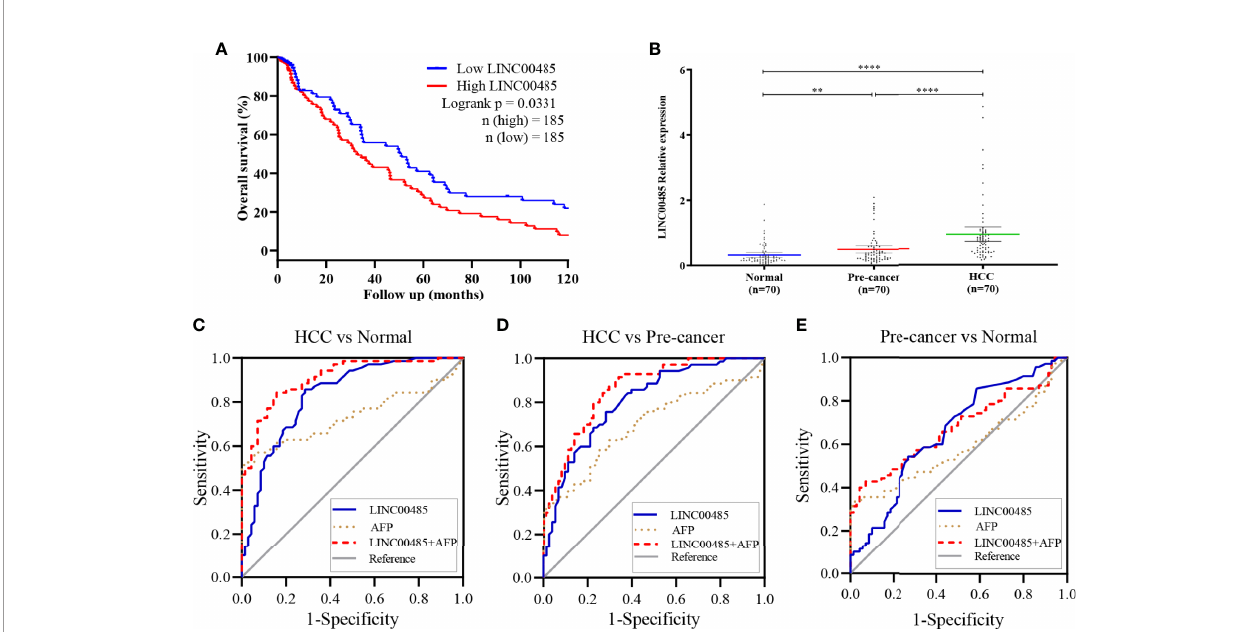
FIGURE 3 | Validation of LINC00485 expression in HCC serum and its prognostic & diagnostic performance. (A) Survival analysis shows the relationship between expression levels of LINC00485 and overall survival of patients with HCC. The X axis represents follow-up time (months) and the Y axis represents survival rate. Different colored curve re fl ects different groups, red re fl ects high LINC00485 group, and blue re fl ects low LINC00485 group. (B) Scatter plot shows the differences between serum expression of LINC00485 in HCC, pre-cancer and normal controls detected by real-time PCR method. **p < 0.01, ****p < 0.0001. ROC curve re fl ects the diagnostic value of LINC00485 and AFP in discriminating: (C) HCC from Normal, (D) HCC from Pre-cancer, and (E) Pre-cancer from Normal. ROC, Receiver operating characteristic. Area under the curve (AUC) represents the diagnostic ef fi